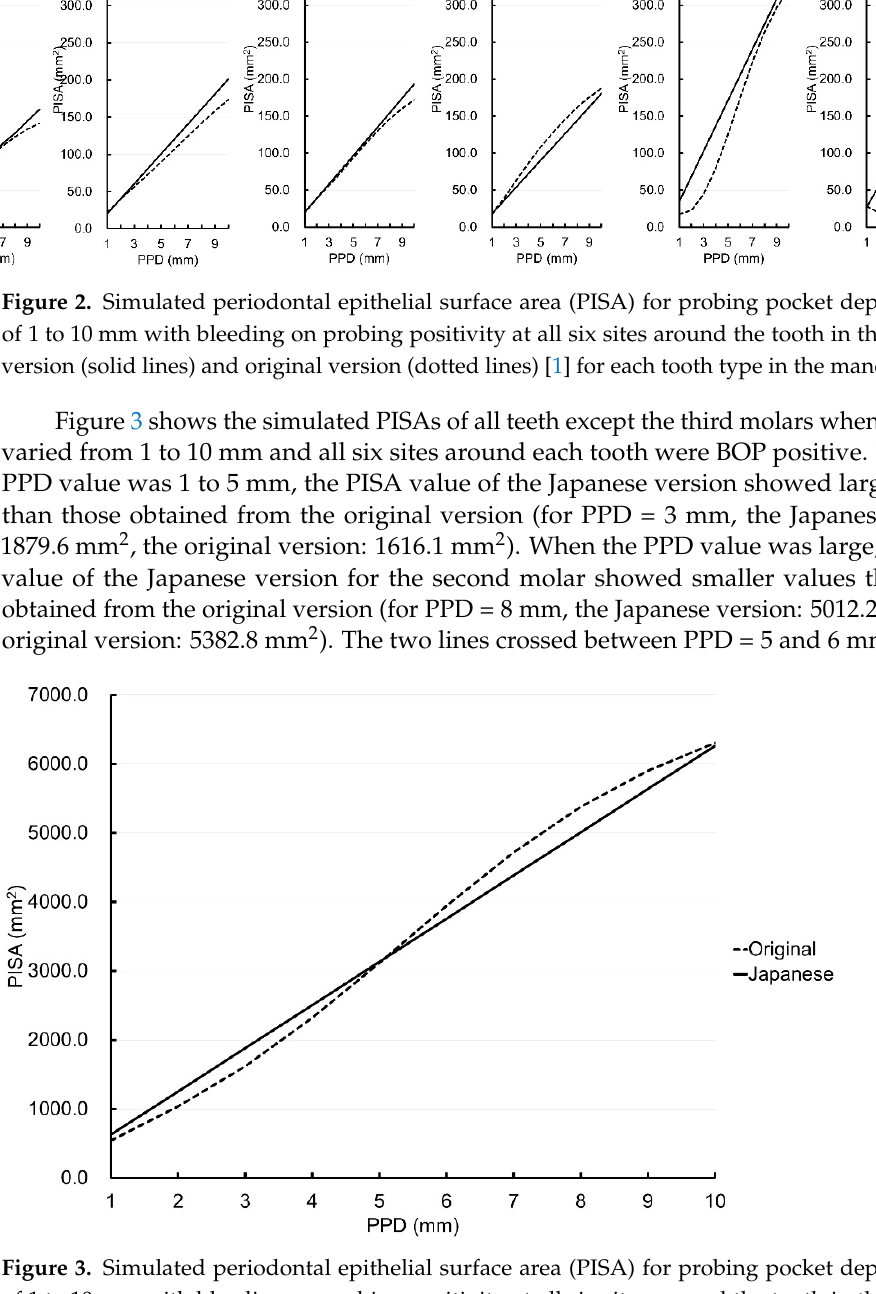
Table 2. Subjects’ characteristics ( n = 210).